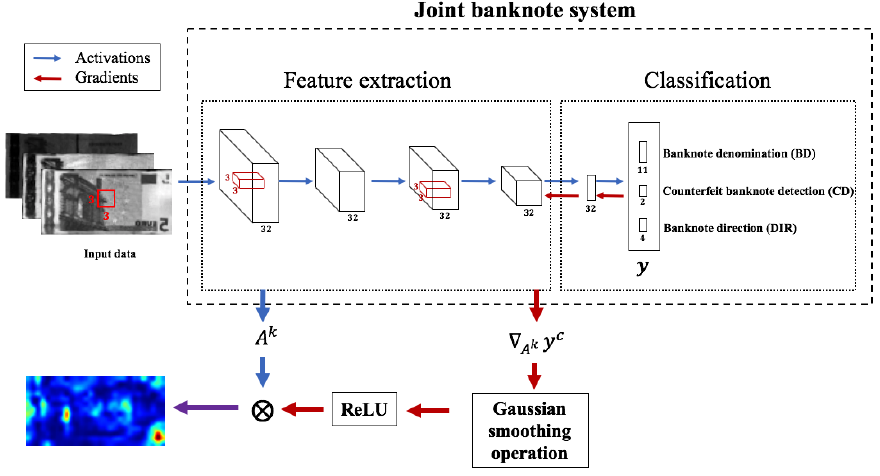
Figure 5. pGrad-Cam